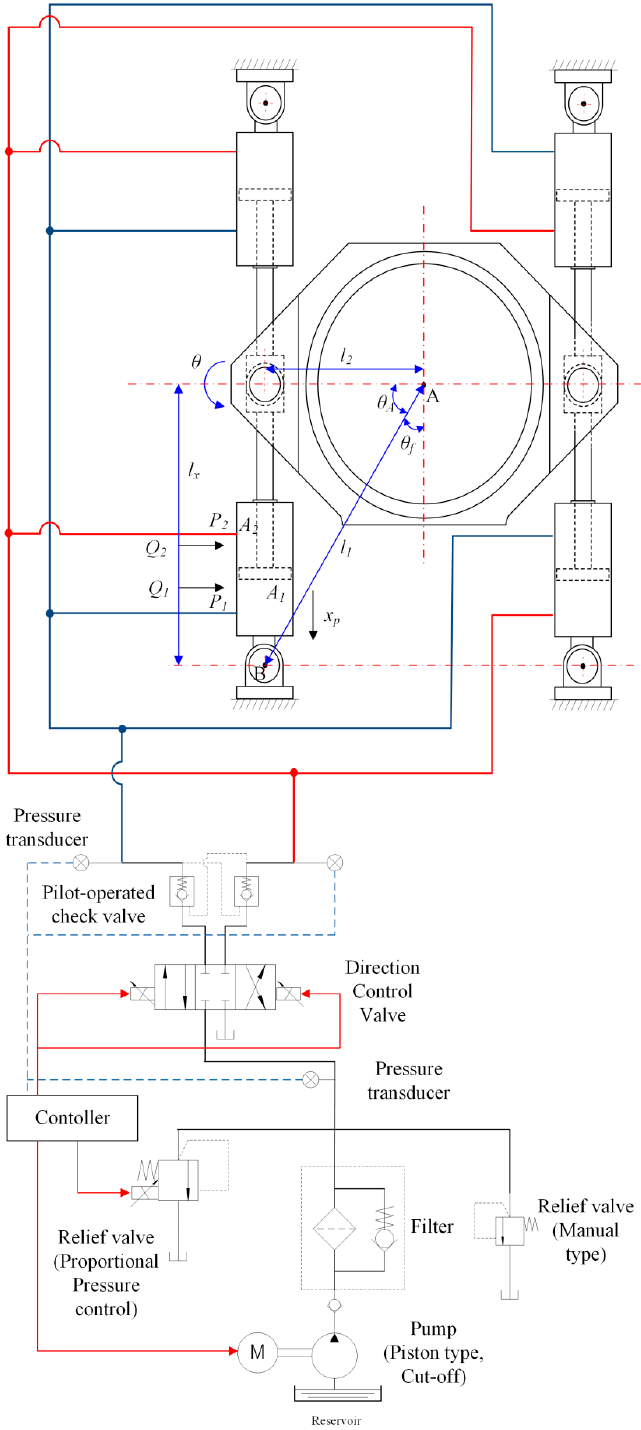
Figure 10. Hydraulic circuit for controlling actuators [11].